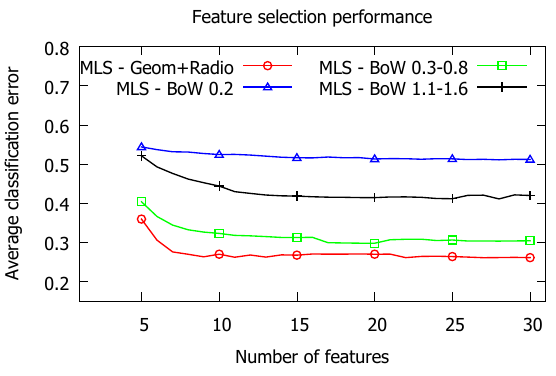
Figure 2. Learning curves describe the average error as a function of feature count; here MLS refers to multispectral point